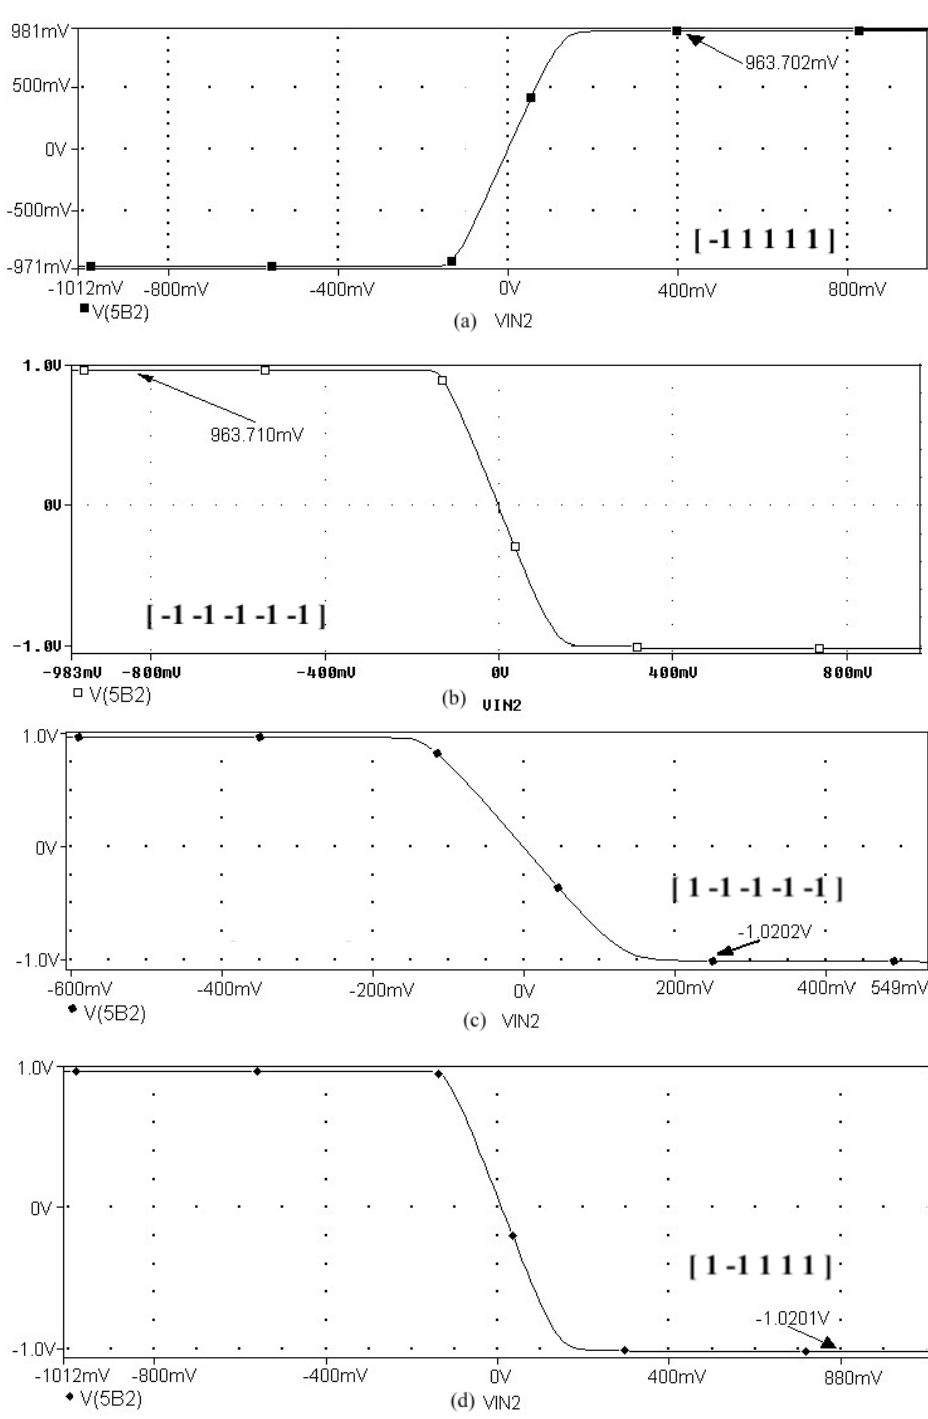
Figure 8. Response of the neural network to different stimulus. The stimulus means external inputs to the network. ( a ) P = [ − 1 1 1 1 1]; T = [1], ( b ) P = [ − 1 − 1 − 1 − 1 − 1]; T = [1], ( c ) P = [1 − 1 − 1 − 1 − 1]; T = [ − 1], and ( d ) P = [1 − 1 1 1 1]; T = [ −